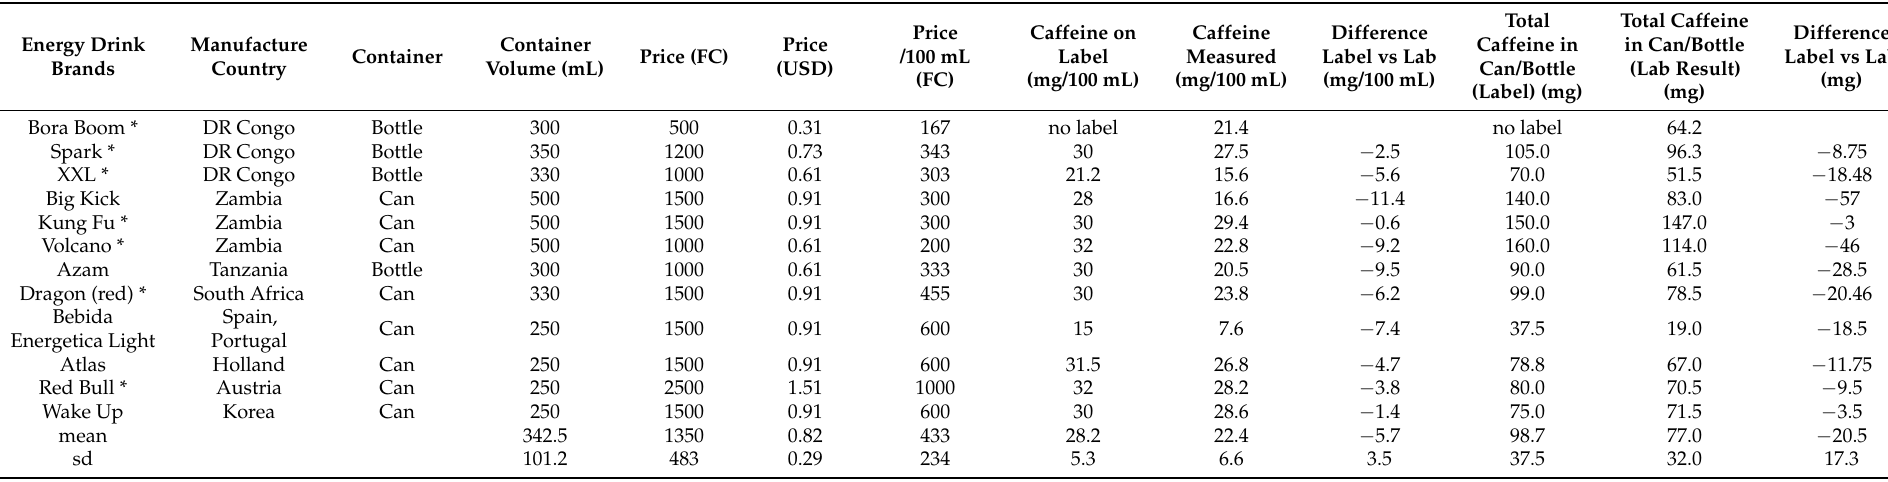
Table 1. Brands of energy drinks sold in Lubumbashi (DR Congo) in December 2018 and their caffeine concentrations on the label and as measured. Energy Drink